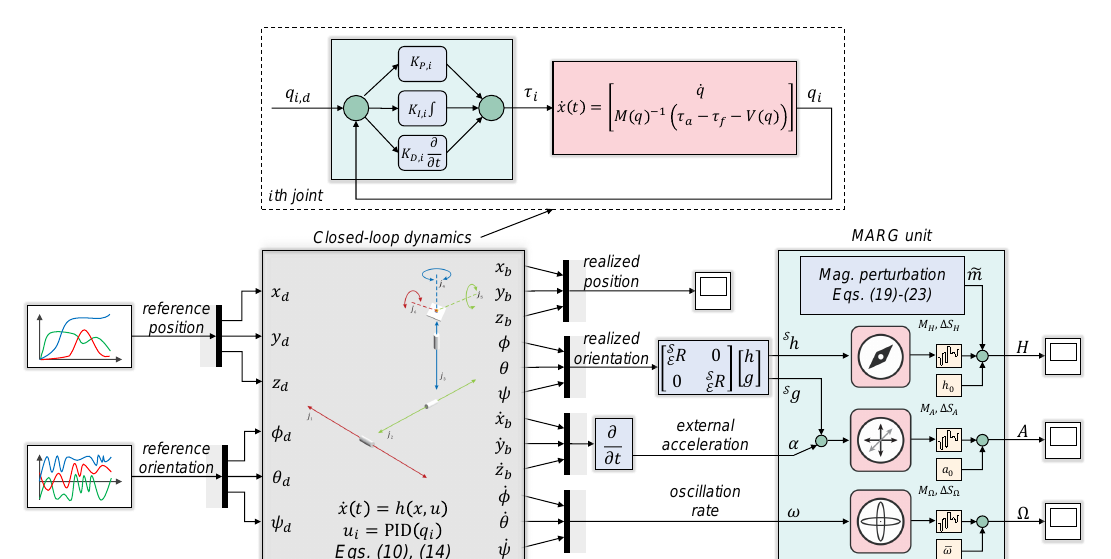
Figure 7. The test environment in